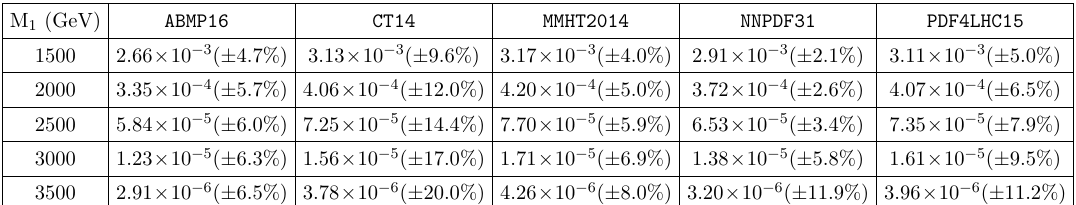
Table 3 . Intrinsic PDF uncertainties in the signal at NNLO QCD for di(cid:11)erent PDF choices are given right at the resonance for di(cid:11)erent M 1 values. All the results are presented for 13 TeV LHC. The cross sections are given for the central set ( n = 0) for each PDF group along with the corresponding intrinsic uncertainties in terms of the